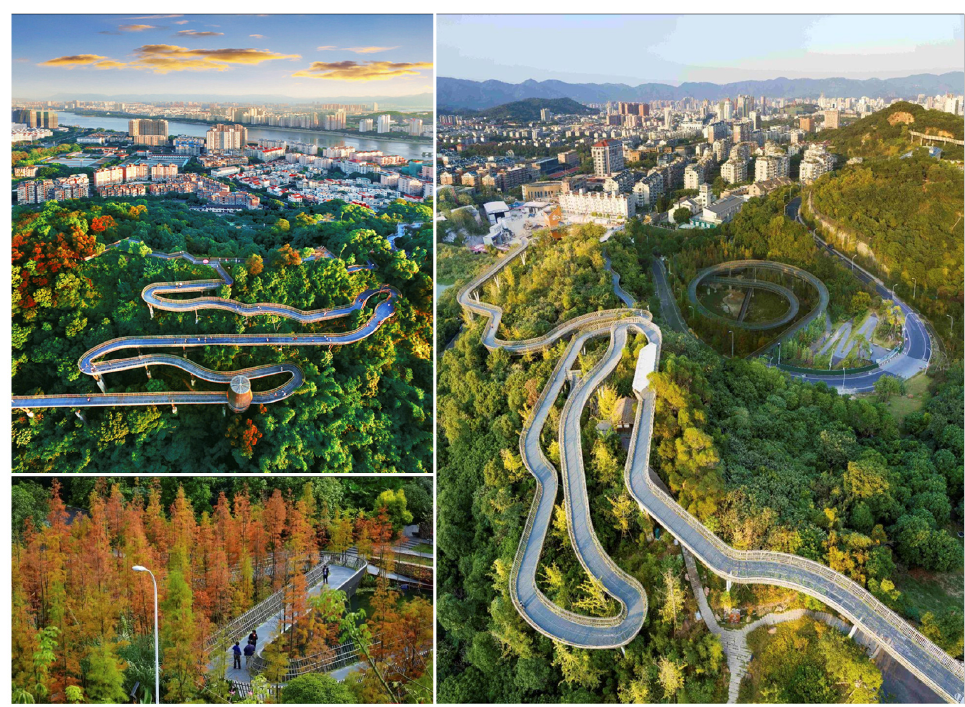
Figure 4. Photos taken from above the Fu Forest trail.